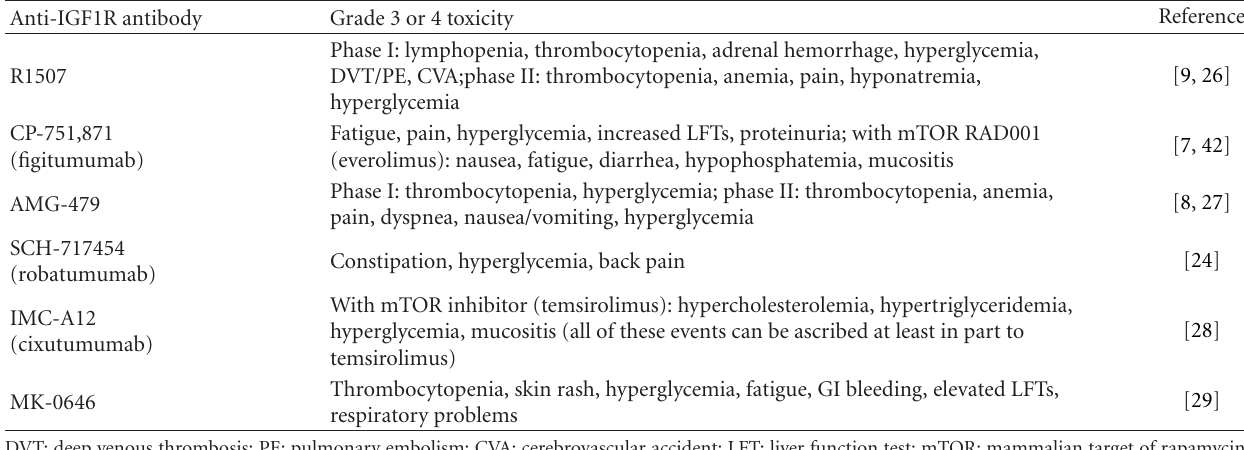
Table 3: Uncommon ( < 10%) Grade 3 and 4 toxicities of antiinsulin-like growth factor 1 receptor (IGF1R) antibodies. Anti-IGF1R antibody